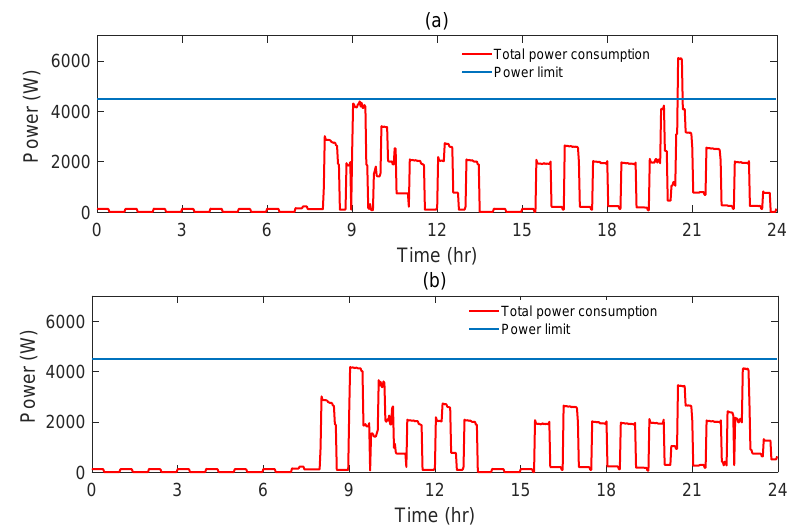
Figure 12. Power consumption graph of both without AS-REMS ( a ) and optimal ( b ) solution for Scenario 3.